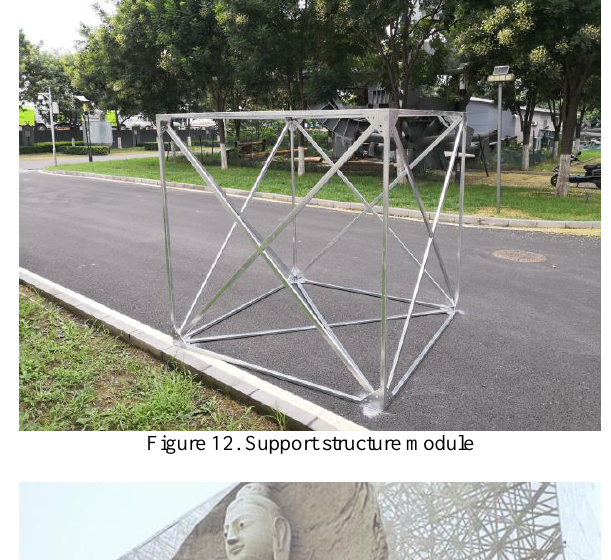
Figure 12. Support structure module